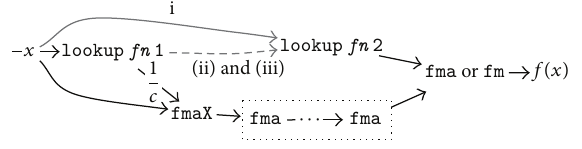
Figure 1: Data flow graph with instructions on vertices, for log 𝑥 , roots, and reciprocals. Most functions follow the same basic pattern or are a composition of such